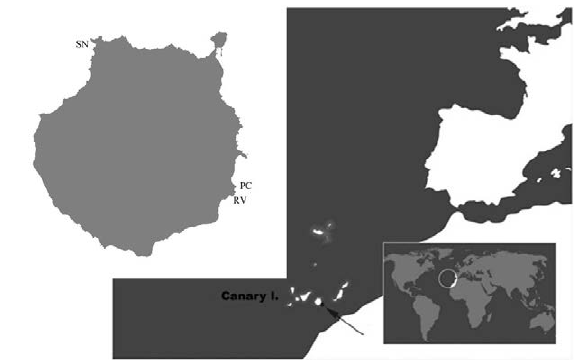
Fig . 1. – Situation of the study area in the eastern Atlantic (right) and study sites in Gran Canaria island